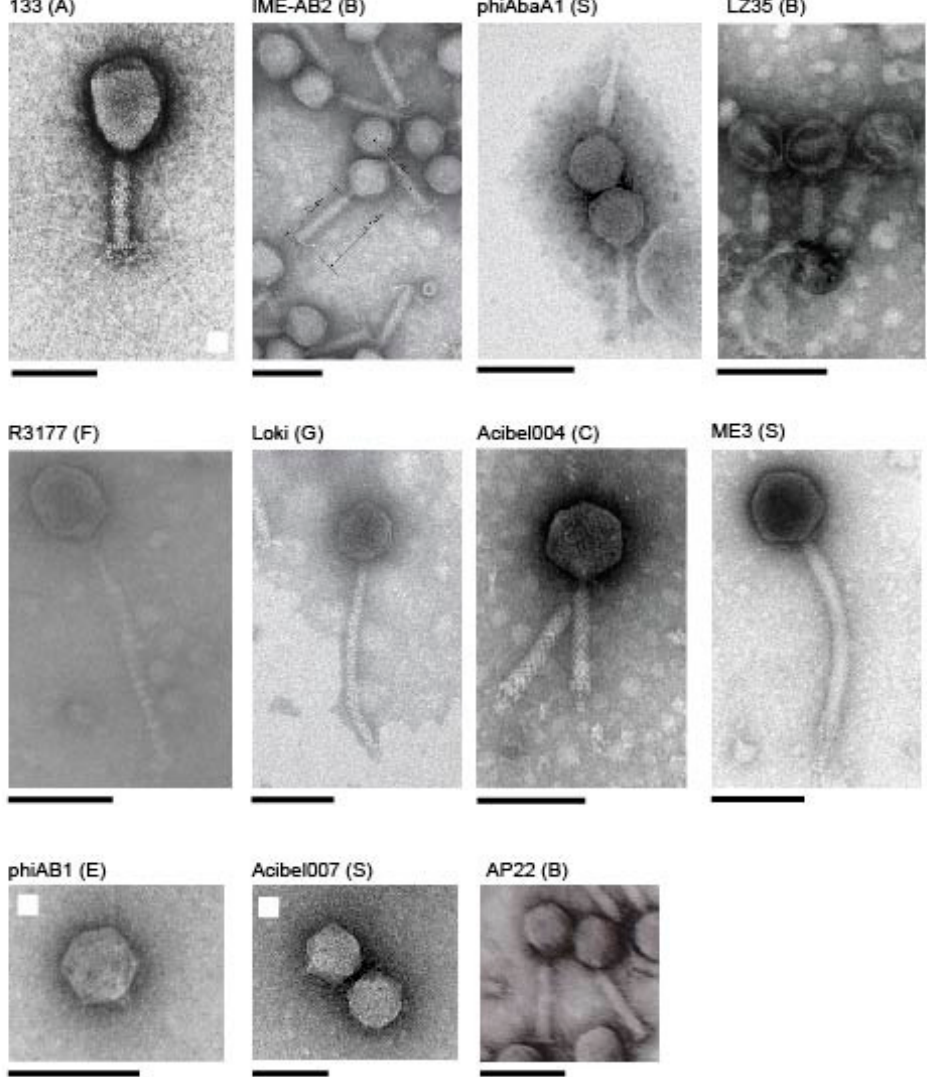
Figure 2. Acinetobacter phage morphologies. Available electron micrographs of Acinetobacter phages representing clusters and genomic singletons. The name of the corresponding phage is labelled above each micrograph with the designated cluster in parenthesis (S; genomic singleton). The scale bars positioned below each micrograph correspond to 100 nm. Electron micrographs of phages 133, IME-AB2, R3177, phiAB1 and Acibel007 are reproduced with permission from [58,59,83,86,87].